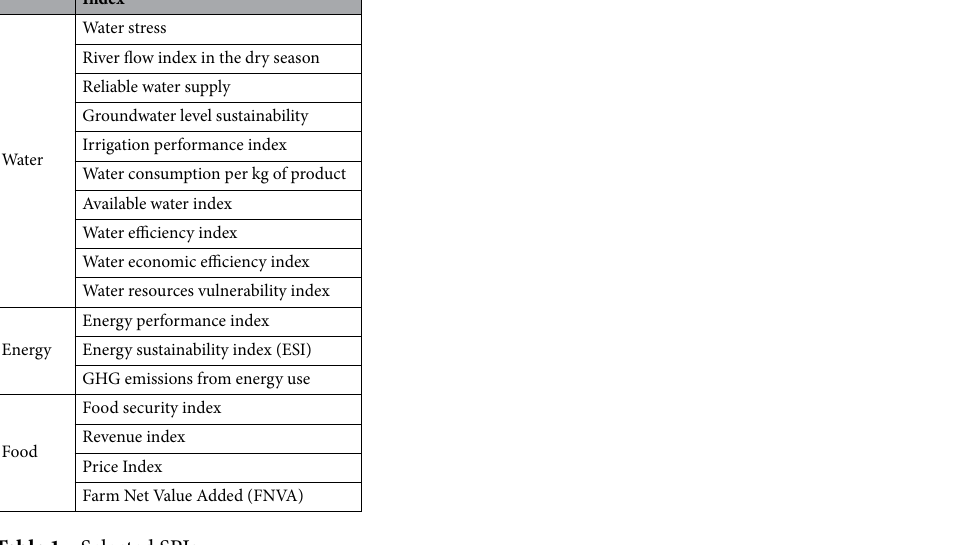
Table 1. Selected